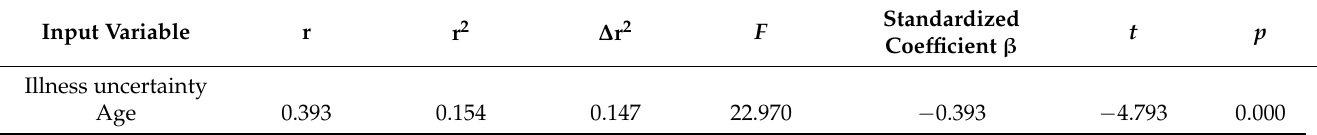
Table 6. Stepwise regression analysis of illness uncertainty in breast cancer